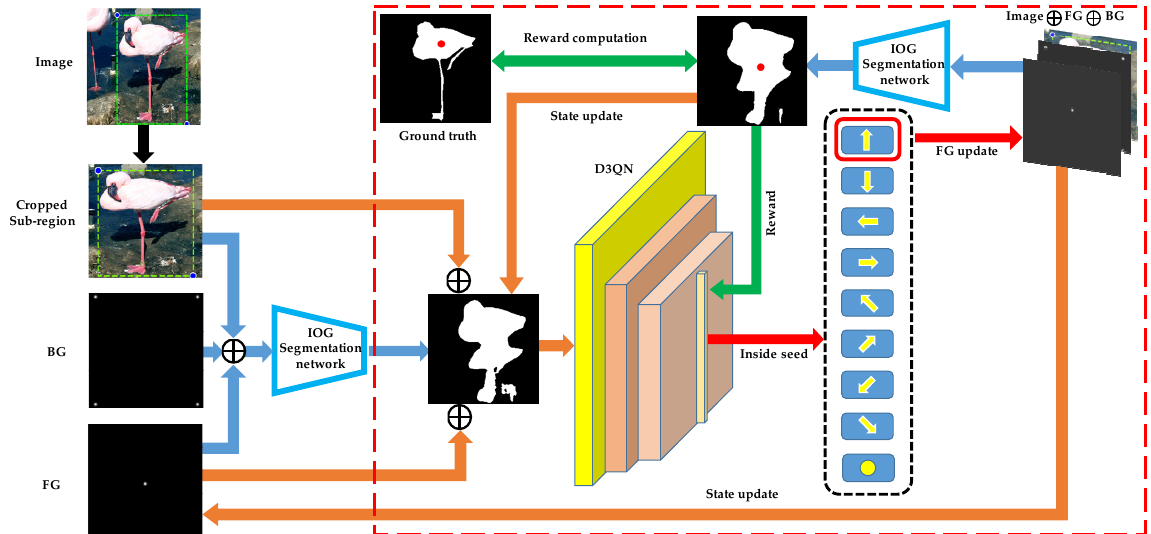
Figure 2. Overview of the proposed IPL-Net. The cropped image, the inside guidance information, and the binary masks are the input of the D3QN. The inside point is updated using the action from the D3QN, and the segmentation mask is obtained using the new inside-outside guidance information. The new segmentation result and the position of the inside point are used to compute the reward, and this process is repeated for a fixed number of steps. The orange, red, and green arrows represent behaviors related to state, action, and reward, respectively. The black rectangle represents the action range.